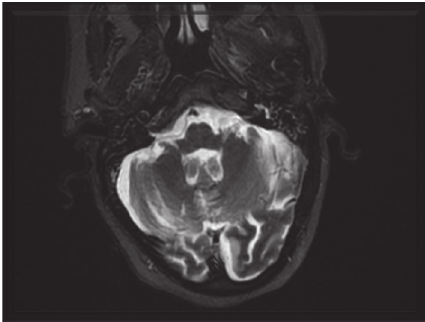
Figure 4: T2-weighted axial MRI following treatment: extensive signal changes in the left infratemporal fossa have resolved.